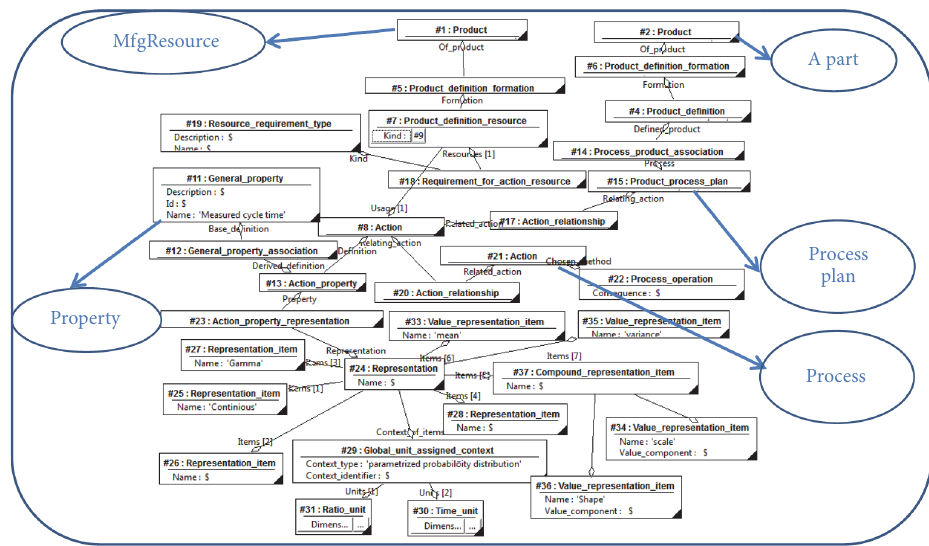
Figure 11: A simplified representation of a manufacturing process using STEP